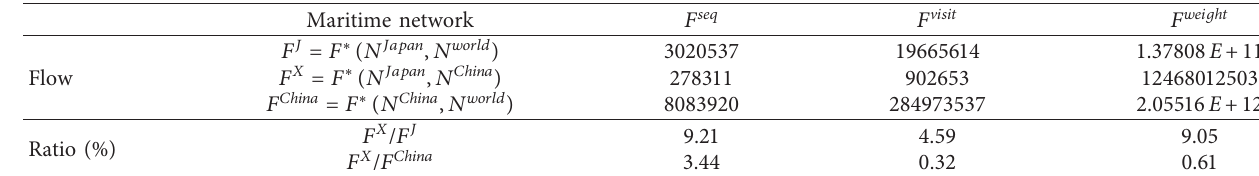
Table 13: Ratios of flows between China and